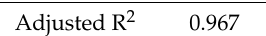
Table 6. Analysis of variance. Log